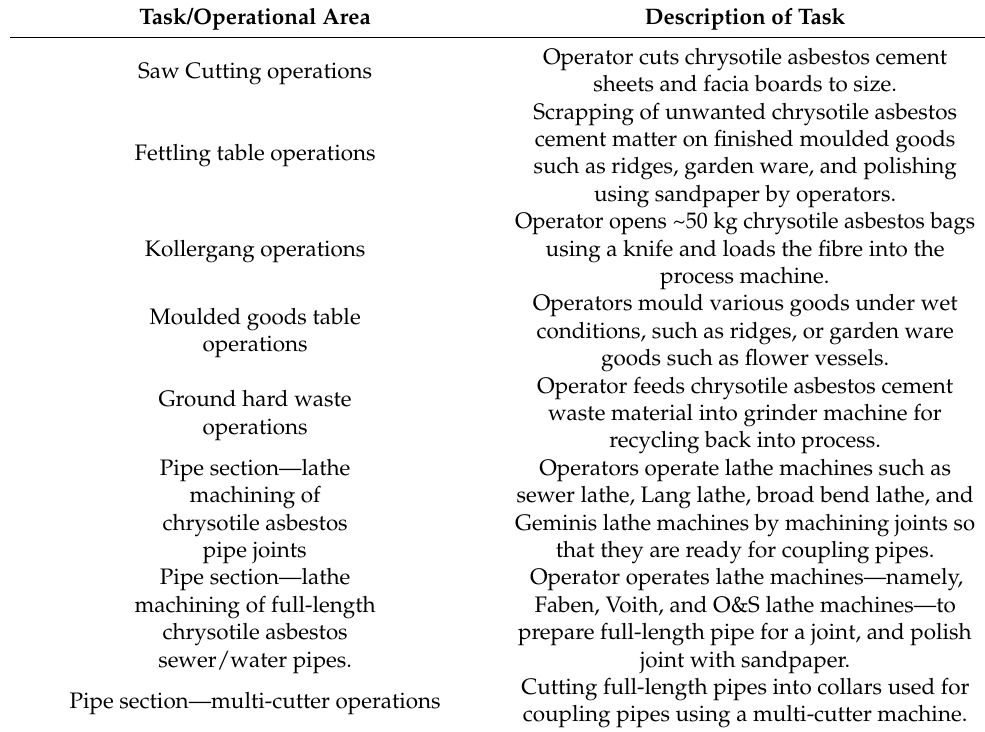
Table 1. Description of tasks and operational areas used in analysing personal chrysotile fibre measurements in the Harare and Bulawayo